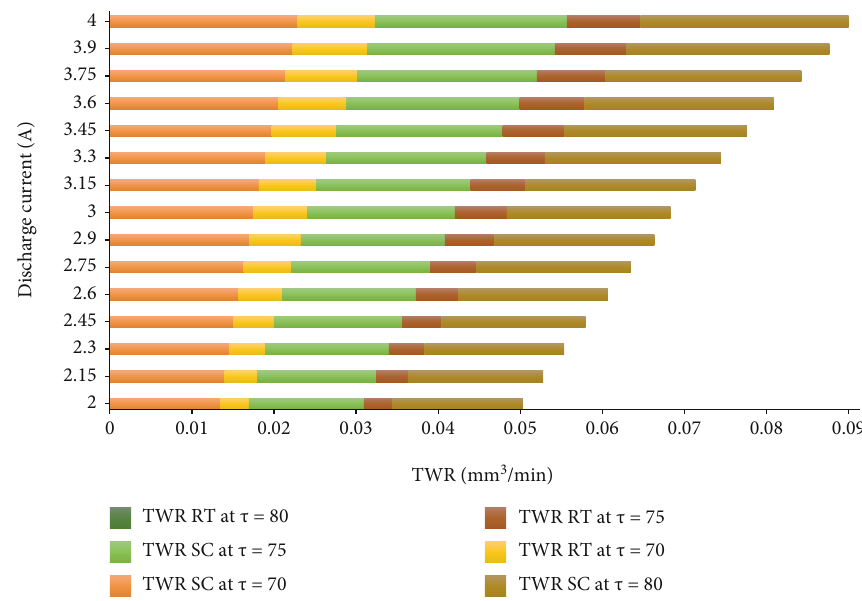
Figure 10: TWR vs. discharge current for two types of electrodes at T